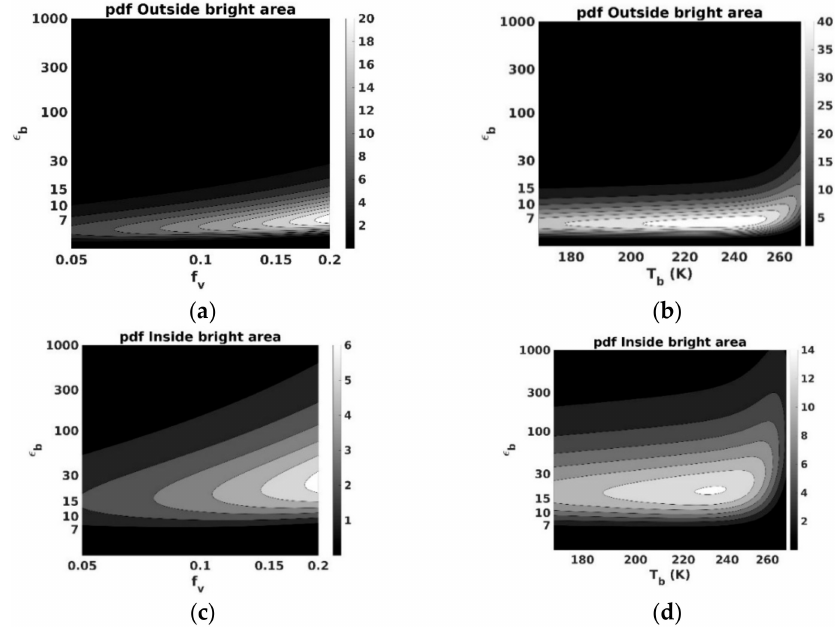
Figure 7. Posterior pdf p p ( ε b ∗ , f v ∗ ) and p p ( ε b ∗ , T b ∗ ) outside ( a ) and ( b ) and inside ( c ) and ( d ) the bright reflector.